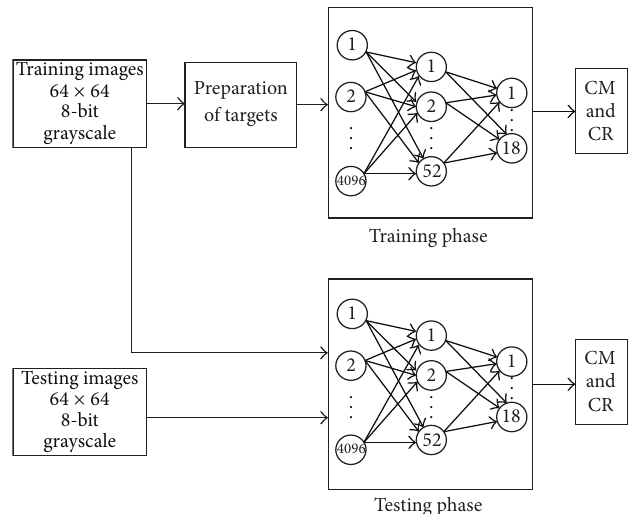
Figure 1: Block diagram of medical image compression